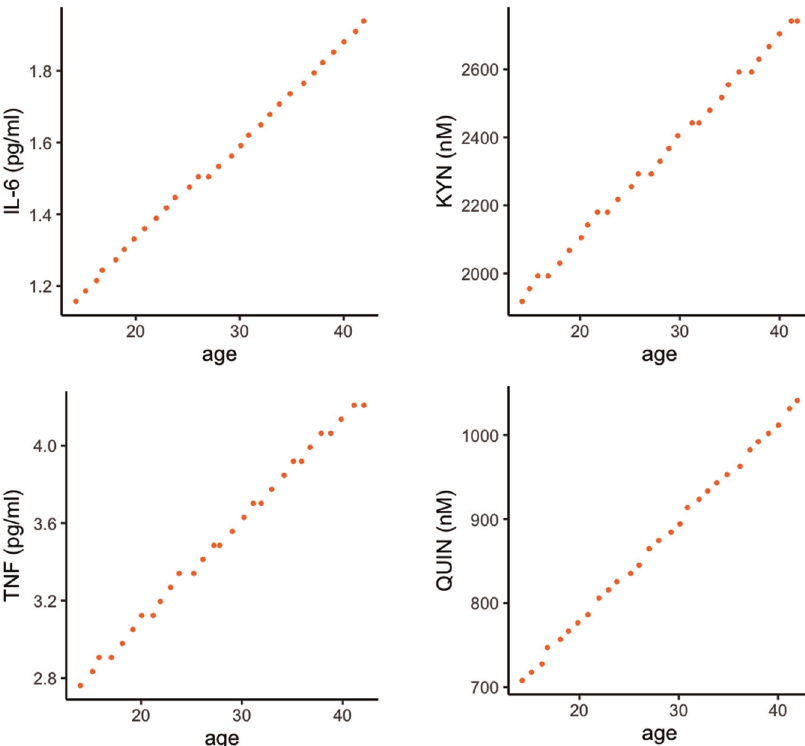
Fig. 3 Depression-warning cut off per age. Bayesian models with fl at priors were used to predict the probability of each 3rd trimester EPDS score based on individual marker levels and age. Plotted here are the minimal marker levels where the most probable EPDS score is ≥ 10 for women ages 18 – 44. As marker levels exceed these plotted thresholds, the probability that a given woman would score ≥ 10 on the EPDS scale in the 3 rd trimester continues to increase asymptotically to 1. An EPDS score of 10 or greater is used clinically to screen women for PPD, thus these plots present a proof-of-concept for an advanced screening method where a woman ’ s age and measures of these 4 markers could jointly be used to fl ag someone as likely to score ≥ 10 on the EPDS assessment in the next trimester and therefore considered to be at risk of developing future